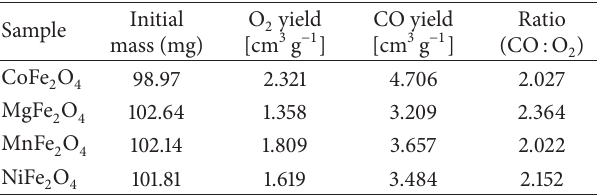
yield for the 5th cycle for the four different Table 2: CO and O 2 mixed metal ferrites in